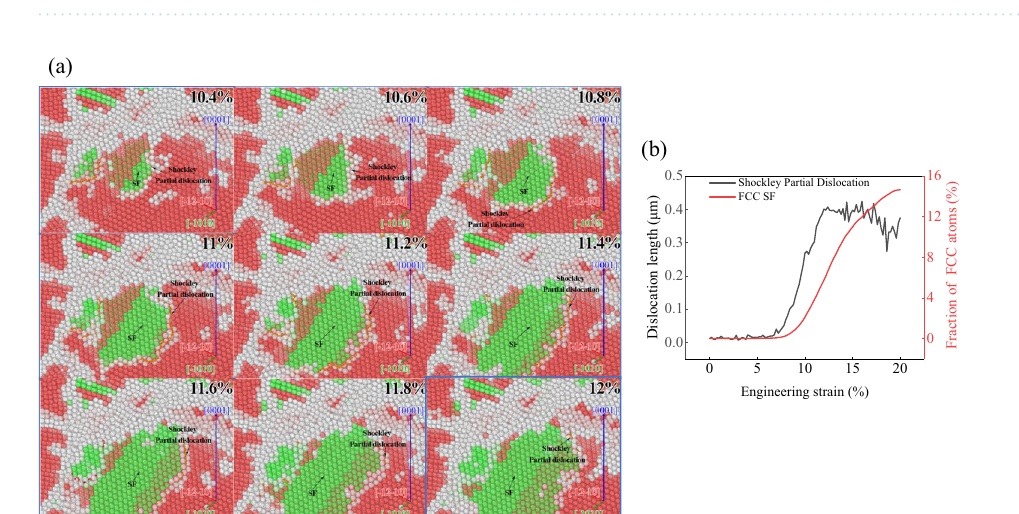
Figure 9. Dislocation evolution and density curve during compression along